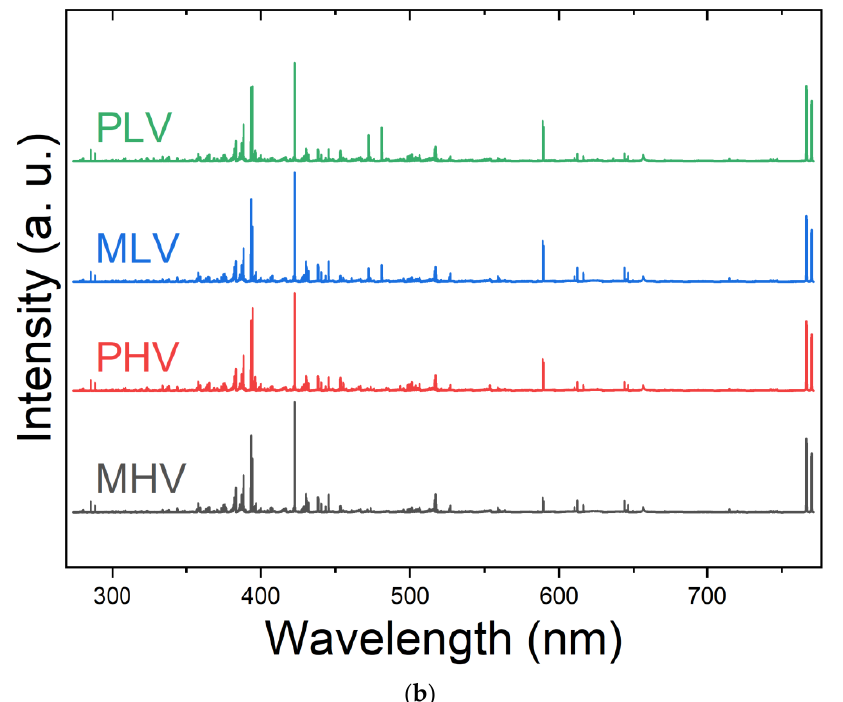
Figure 1. LIBS average spectra separated by cultivar and vigor classes, where MHV = Marandu High Vigor; PHV = Paiaguás High Vigor; MLV = Marandu Low Vigor; and PLV = Paiaguás Low Vigor: ( a ) UV region and ( b ) VIS region.